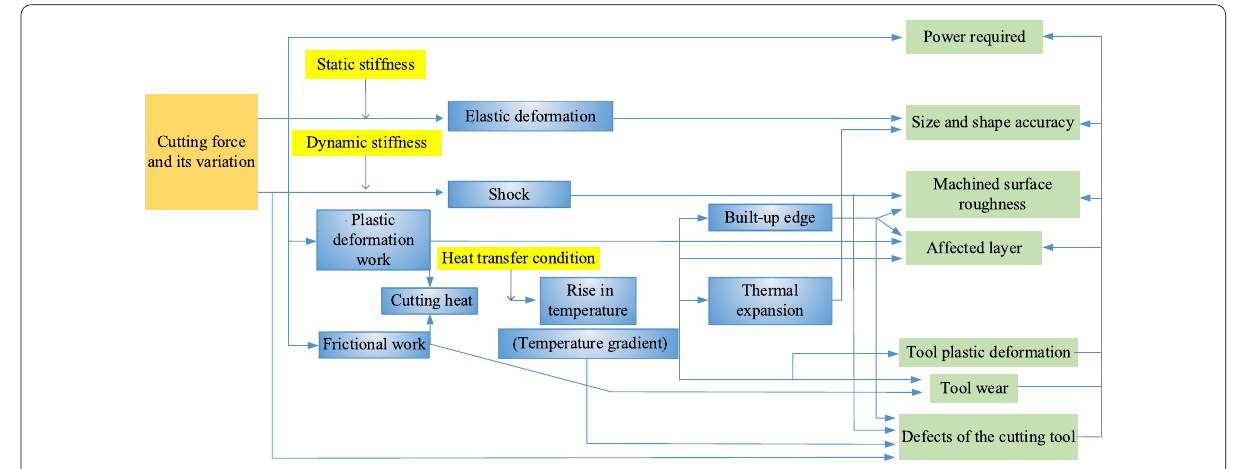
Figure 2 Effect of milling